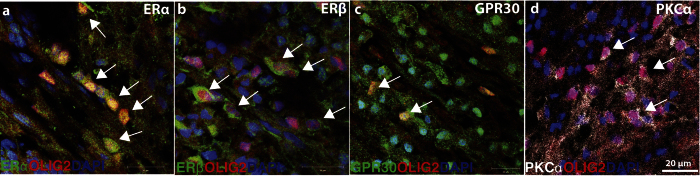
Expression of estrogen receptors and active PKCα at 14 pli.(a–d) Representative images taken at 40 × showing expression of estrogen receptors ERα, ERβ and GPR30 (green) and phosphorylated (active) PKCα (white) by OLIG2 + oligodendrocyte lineage cells (red) in CCP lesions 14 days post ethidium bromide injection (pli). White arrows point ERs + or PKCα + /OLIG2 + cells. Scale bar: 20 μm.